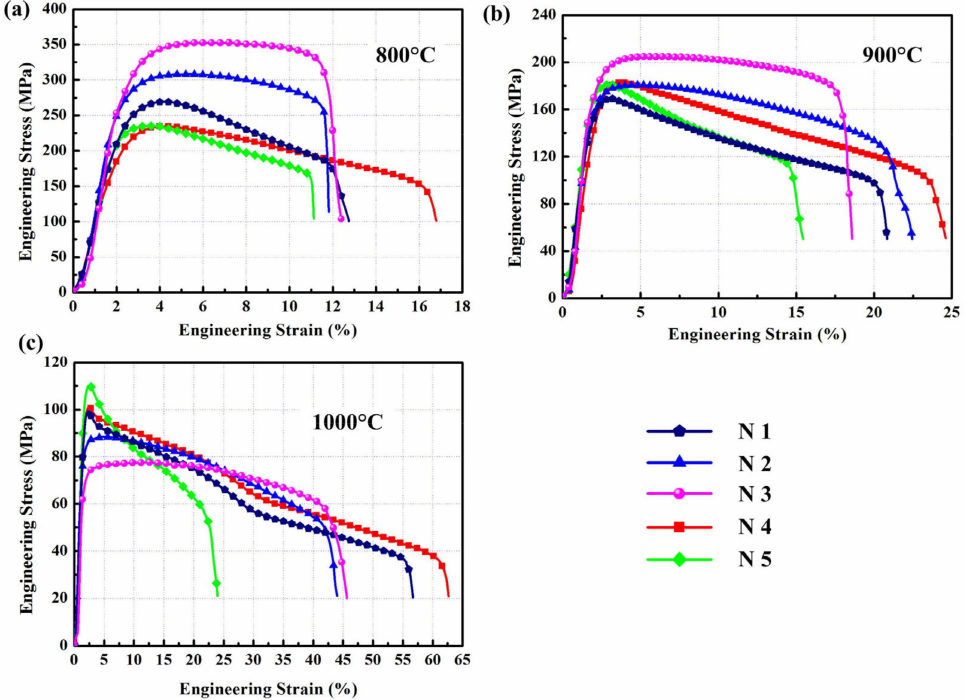
Figure 8. Tensile stress–strain curves of the laminated composites at elevated temperatures: ( a ) 800 ◦ C;